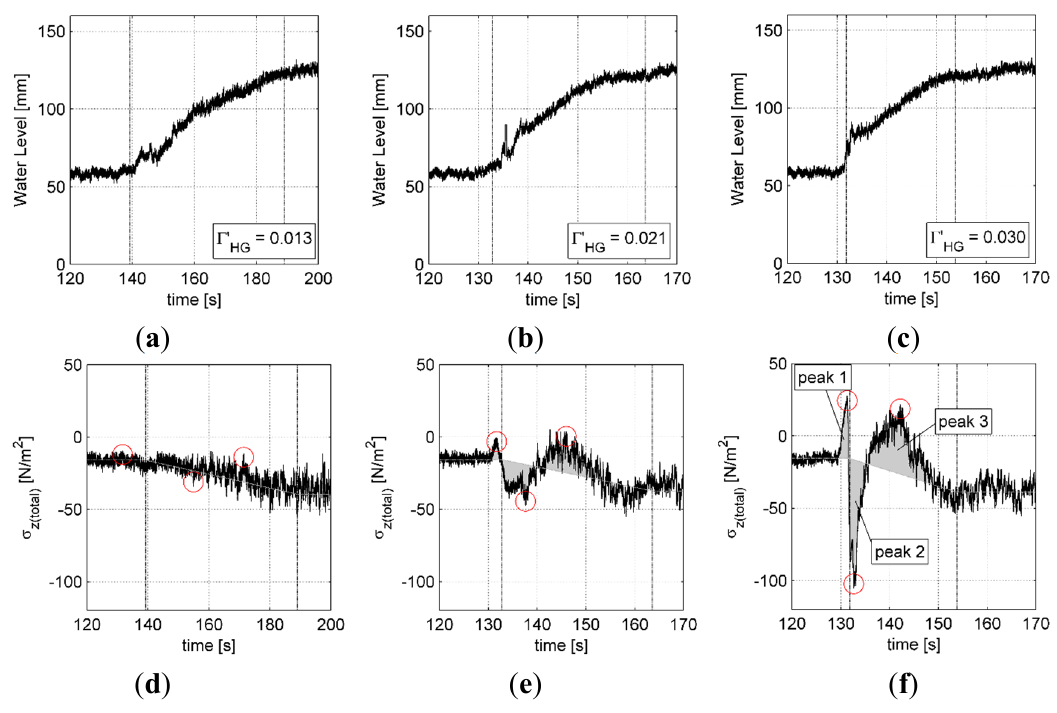
Figure 6. Water level above roughness tops and measured total lift over time during flow increase at three different ramping rates. d initial = 57 mm, d max = 128 mm, ( a , d ) Δ t R = 49.8 s; (cid:4593) = 0.013; ( b , e ) Δ t (cid:4593) = 0.021; ( c , f ) Δ t (cid:4593) = (cid:1985) R = 30.8 s; (cid:1985) (cid:3009)(cid:3008) R = 22.0 s; (cid:1985) (cid:3009)(cid:3008) (cid:3009)(cid:3008)